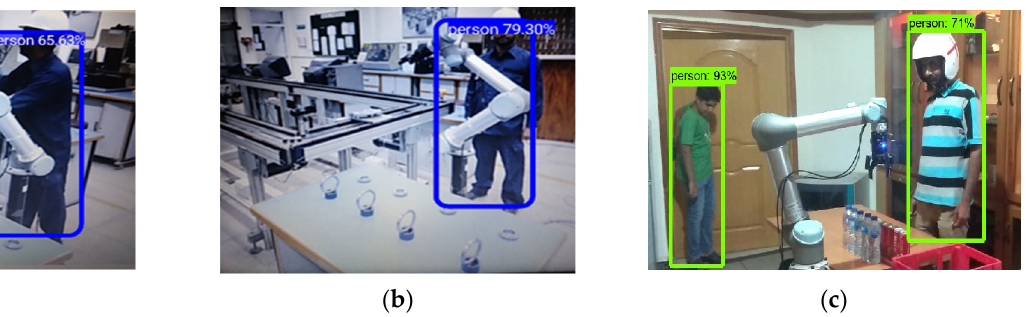
Figure 6. Detection of persons through object detection algorithm, ( a ) operator in blue and uniden- tified person in red; ( b ) authorized operator; ( c ) operator and unidentified person.